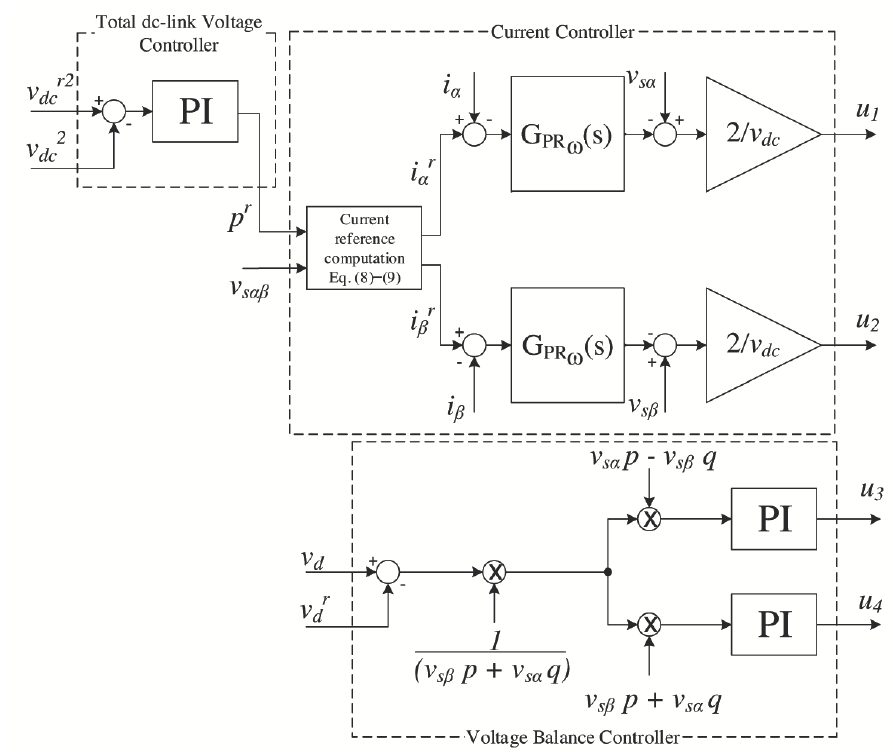
Figure 2. Complete schematic block diagram of the